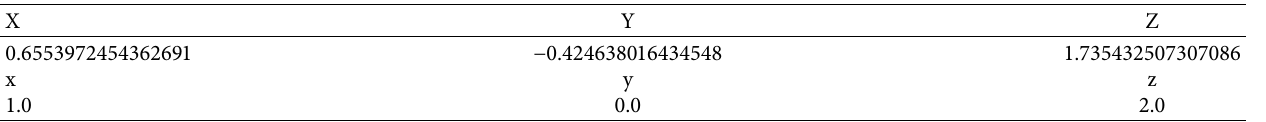
Table 3: Solution of the initially unknown confguration and aim confguration of the 3-bar structure in Figure 9 with nonlinear truss elements.